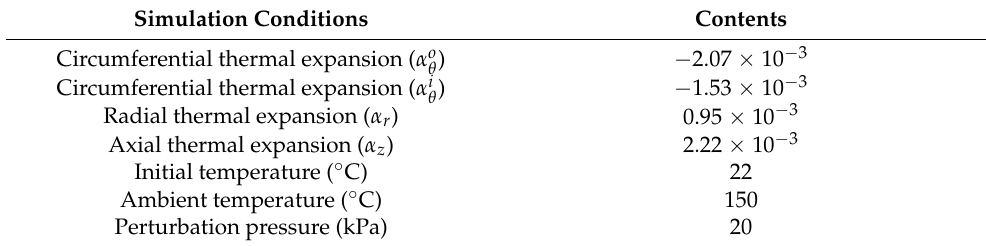
Table 4. Directional thermal expansion coefficients and the relevant simulation conditions.